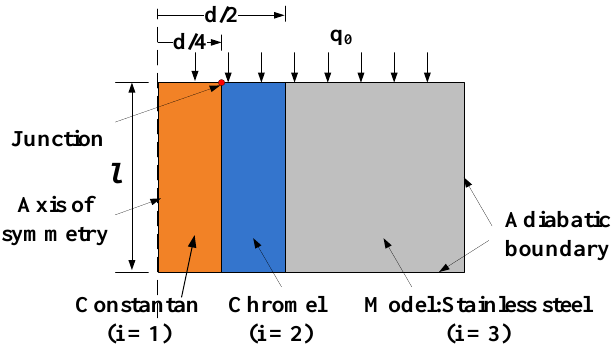
Figure 4. Two-dimensional numerical calculation model (not to scale, units in mm).